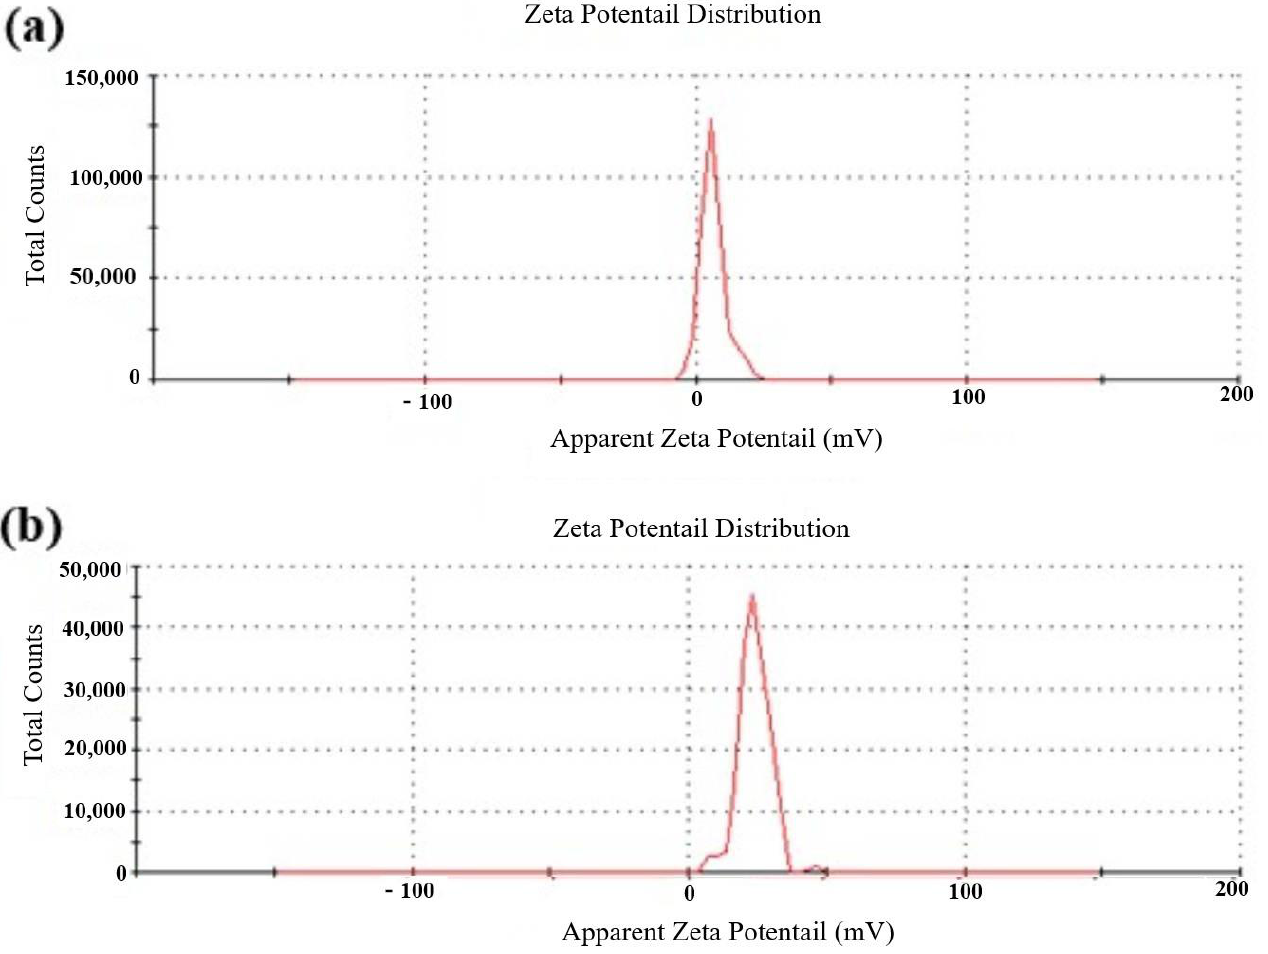
Figure 6. Two-dimensional atomic force microscopy ( a ) and three-dimensional atomic force microscopy ( b ) of Metarhizium anisopliae – chitosan nanoparticles. The zeta potential of M. anisopliae conidia was 6.22 mV (Figure 7a), whereas the zeta potential of M. anisopliae – chitosan nanoparticles was 23.27 mV (Figure 7b).